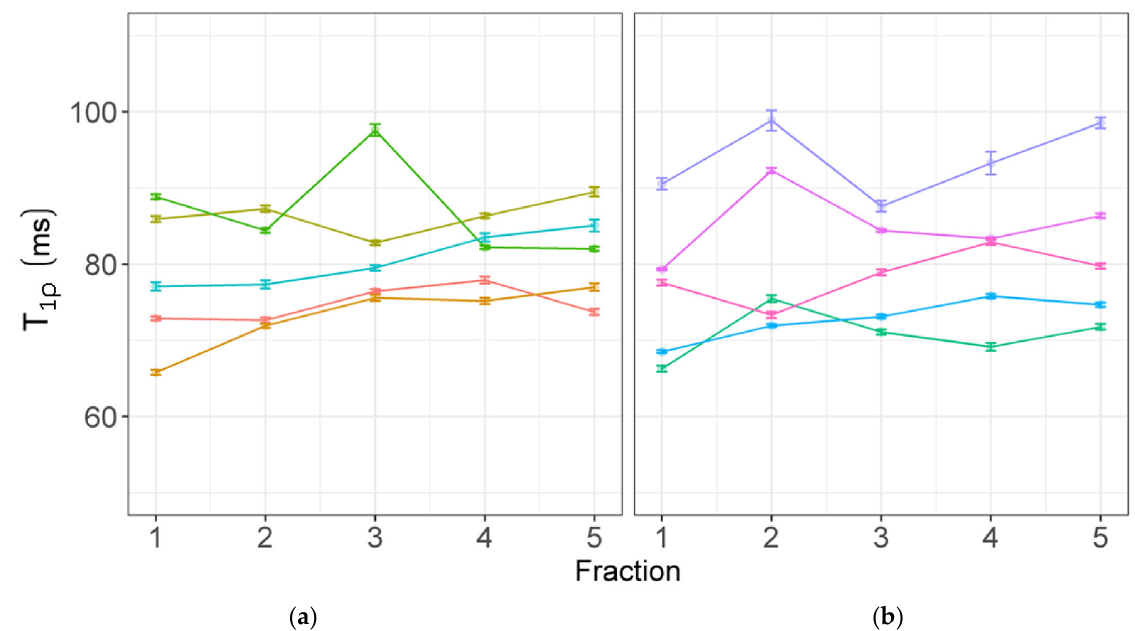
Figure 3. T 1 ρ relaxation times from individual patients for each fraction; ( a ) complete responders; ( b ) incomplete responders. The mean ± standard error of the mean is shown from all voxels inside the GTV. Each line (and color) shows a different patient.